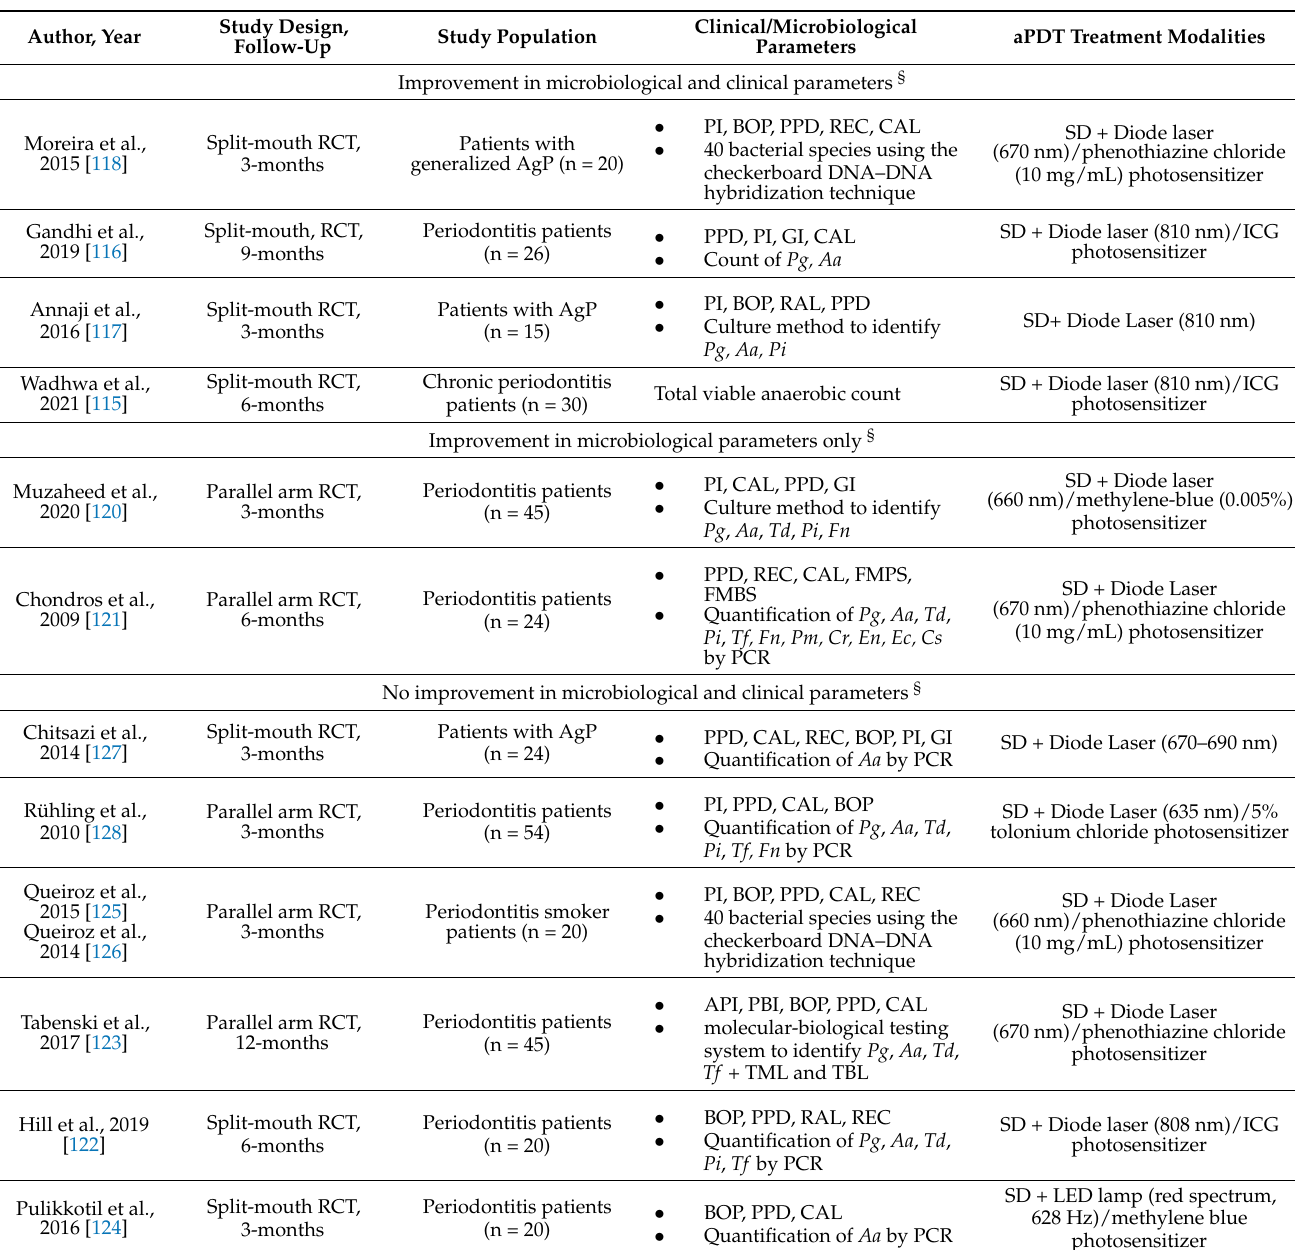
Table 4. Efficacy of laser and antimicrobial photodynamic therapy as adjuncts to nonsurgical peri- odontal therapy on microbiological and clinical